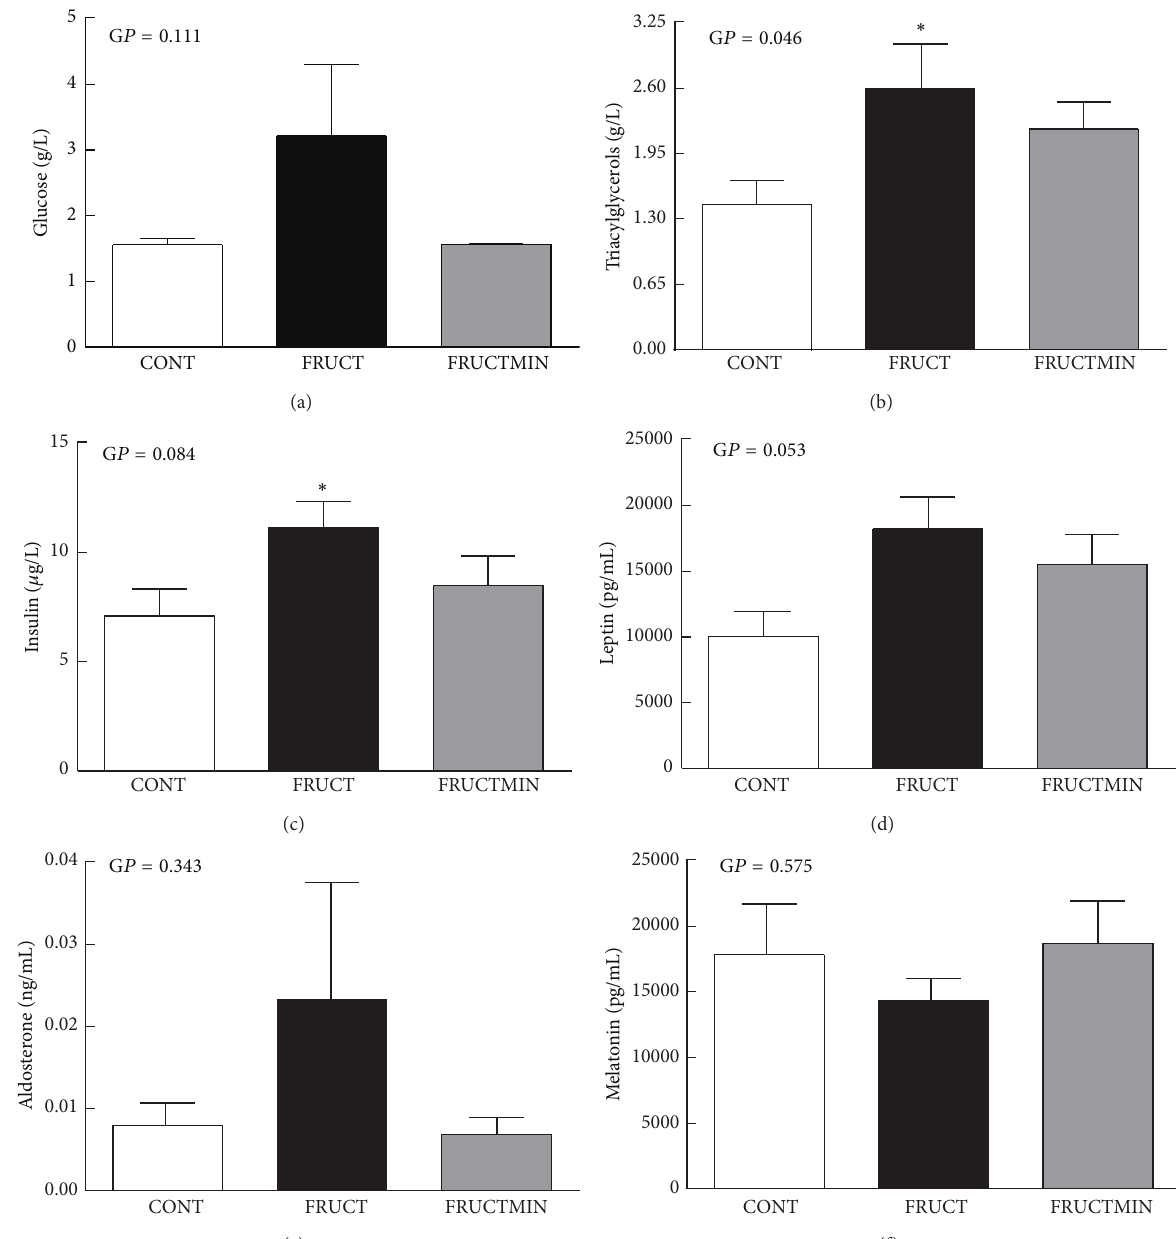
Figure 6: Metabolic markers and hormonal status in plasma. (a) Glucose (g/L; 𝑛 = 7 ), (b) triacylglycerols (g/L; 𝑛 = 5 –7), (c) insulin ( 𝜇 g/L; 𝑛 = 7 ), (d) leptin (pg/mL; 𝑛 = 6 ), (e) aldosterone (ng/mL; 𝑛 = 7 ), and (f) melatonin levels (pg/mL; 𝑛 = 6 ), at the end of the dietary intervention. Results were expressed as mean ± standard error of the mean. ∗ 𝑃 < 0.05 CONT versus FRUCT. CONT: control; FRUCT: